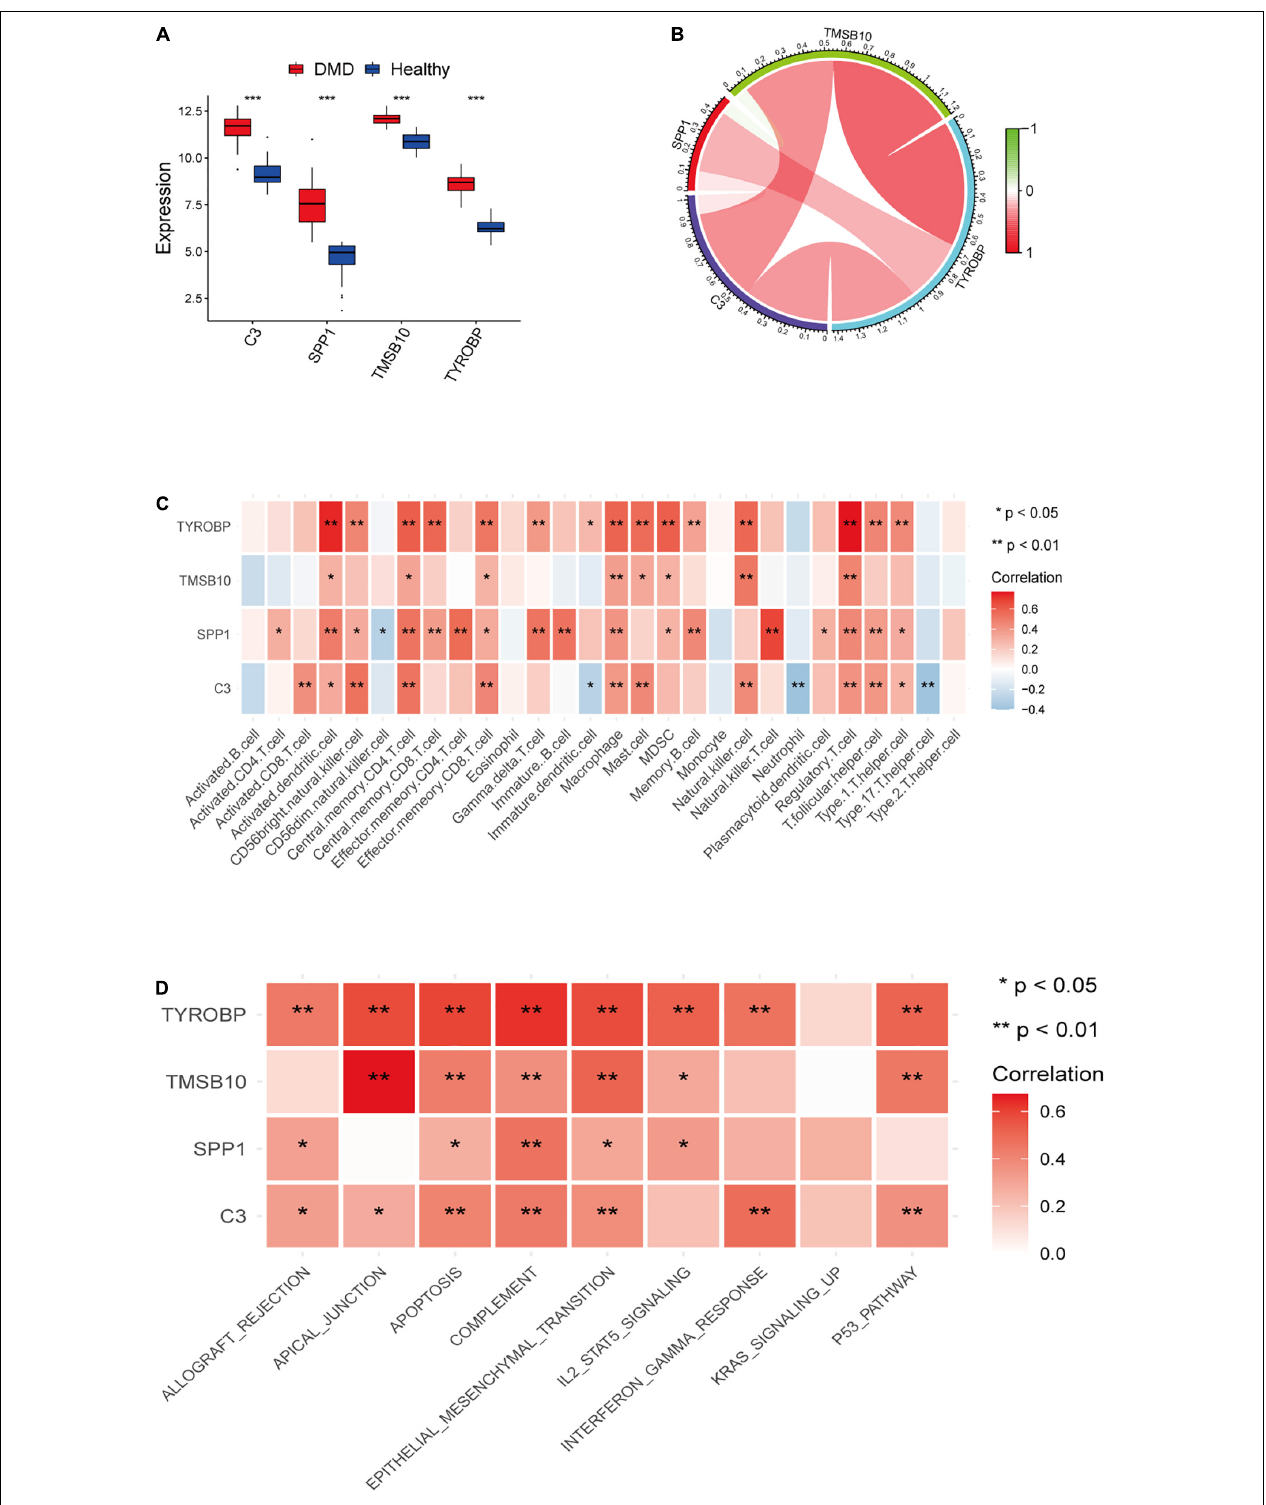
FIGURE 6 | (A) Box plot of the expression differences of candidate genes between the DMD group and healthy control group. (B) A map of expression correlation between candidate genes in the model; red indicates a positive correlation while blue indicates a negative correlation; the darker the color, the stronger the correlation. (C) Heatmap showing correlation analysis between candidate genes and 28 immune cells. (D) Heatmap showing the relationship between candidate genes and potential immune pathways. Red represents a positive correlation. * P < 0.05; ** P < 0.01; *** P < 0.001.